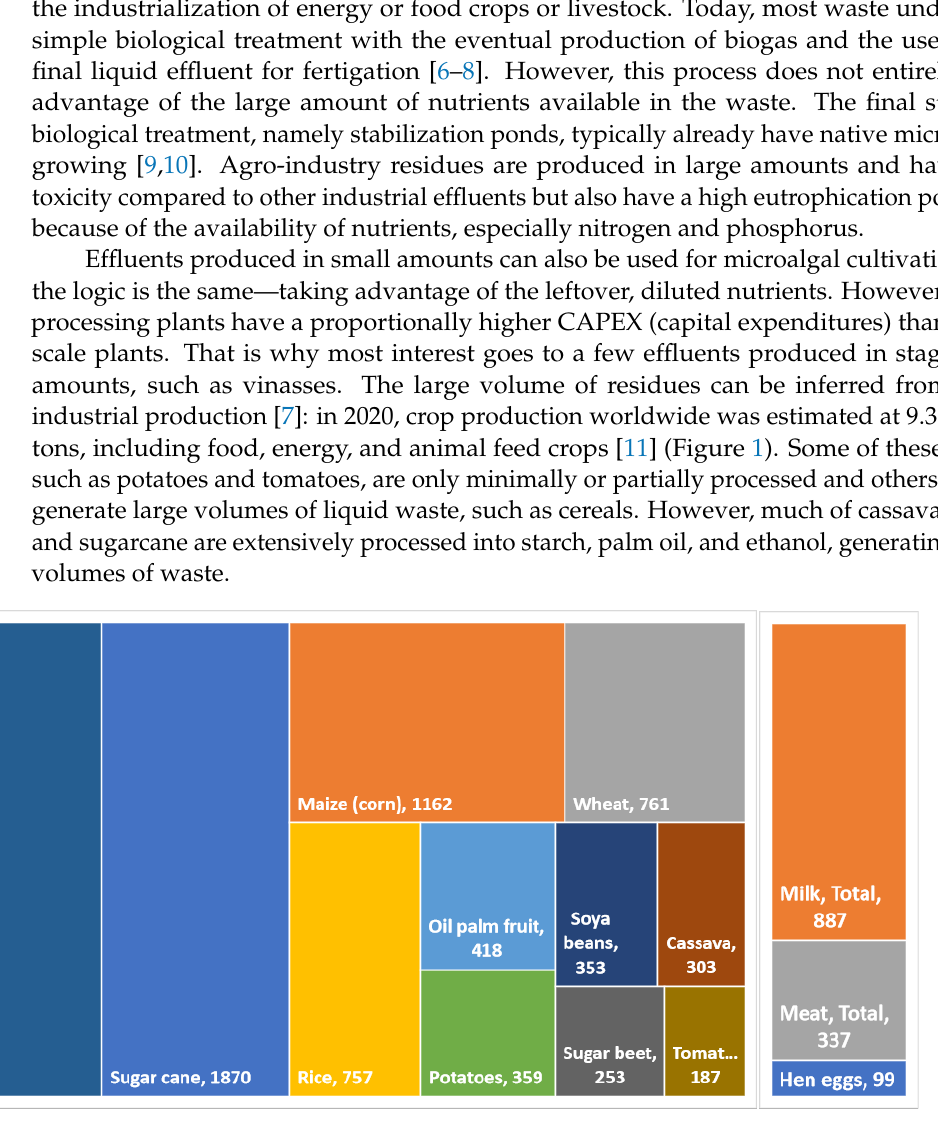
Figure 1. Food and energy crops and animal products in the world in 2020, in million tons. Data compiled from the FAO database [11]. Egg production was converted assuming 60 g/egg.